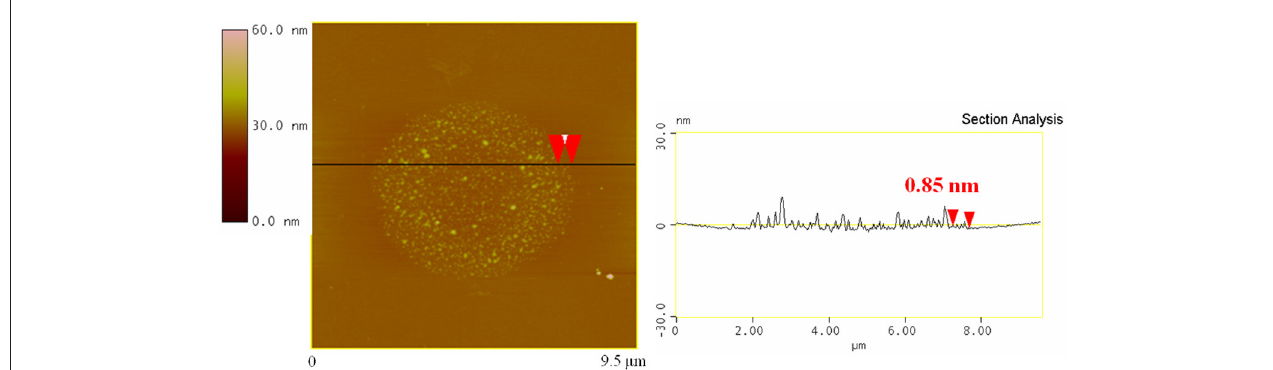
FIGURE 6 | AFM micrograph (Left) and cross section analysis (Right) of bgl/GO-C 2 -NH 2 .